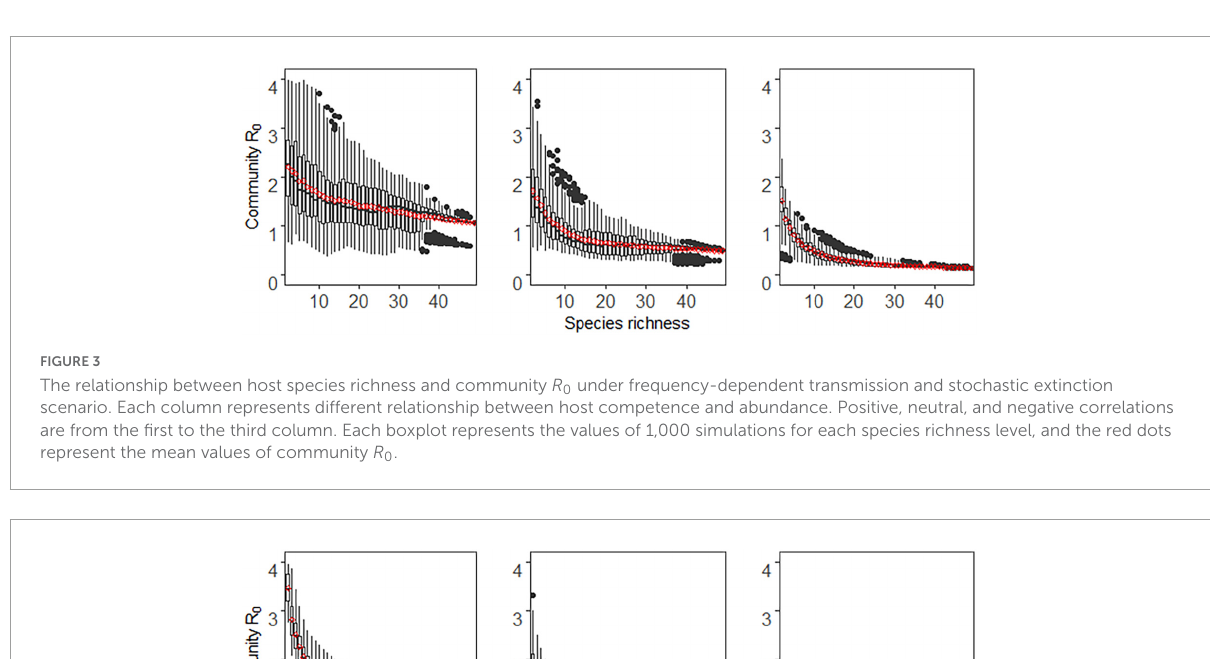
Frontiers in Ecology and